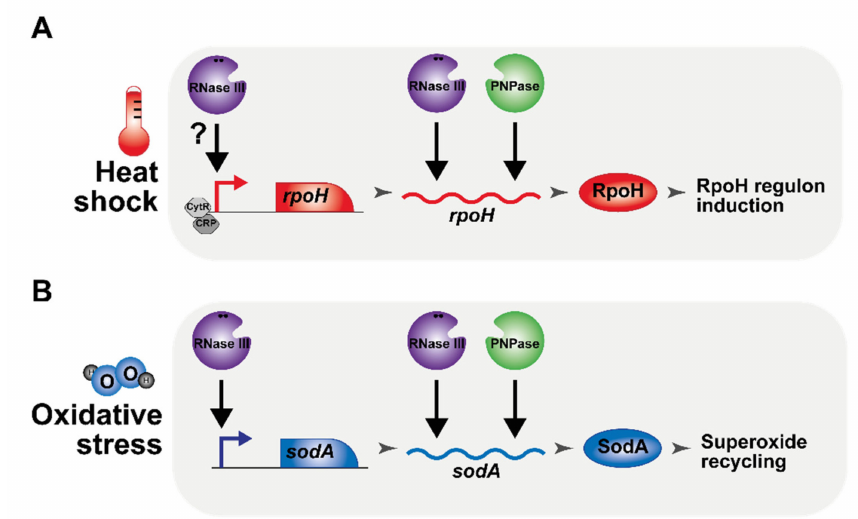
Figure 8. Schematic regulatory roles of RNase III in the adaptation to heat and to oxidative stress. ( A ) RNase III (purple) and PNPase (green) are required for the induction of rpoH (red) independently from the transcription factors CRP (dark grey) and CytR (grey). ( B ) RNase III and PNPase are important for the expression of the superoxide dismutase SodA (blue). Positive regulatory events (direct or indirect) are represented by a black